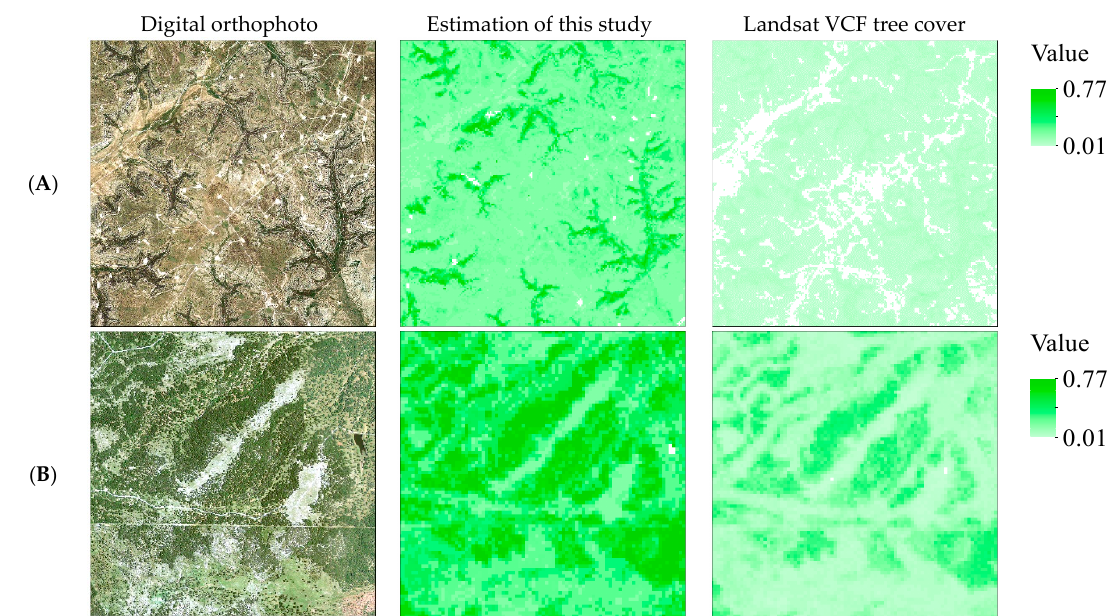
Figure 7. Comparison of the estimated fractional woody cover of this study and Landsat tree cover product in areas ( A ) and ( B ) to 1 m resolution digital orthophotos.